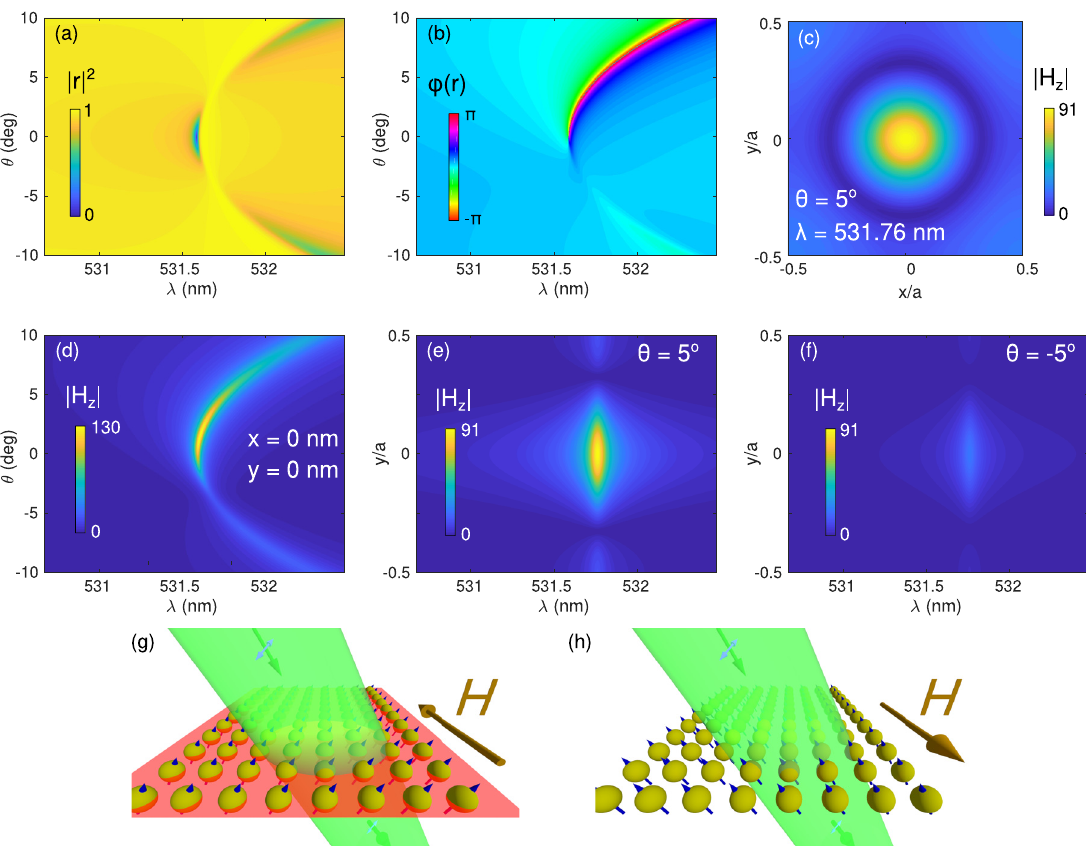
Figure 4: (a and b) Contour maps of the (a) intensity and (b) phase of the reflectance complex amplitude r ( 𝜔 ) (where R ( 𝜔 ) = | r ( 𝜔 ) | 2 ) for TE polarization from an infinite square array of lossless semiconductor ( n = 3 . 5) nanospheres (lattice period a = 300 nm, sphere diameter D = 150 nm), as in Figure 2a and c , but for fixed MO activity 𝛽 = 1, as a function of the angle of incidence and wavelength 𝜆 , theoretically calculated through CEMD, exploring the angular dependence of the MD quasi-BIC. (c–f) Contour maps of the amplitude of the vertical magnetic near-field, calculated also through our analytical CEMD theory, all of them at a distance of z = 100 nm above the square array: (c) within a unit cell at the wavelength ( 𝜆 = 531 . 76 nm) and angle 𝜃 = 5 ◦ of the Brewster quasi MO-BIC; (d) spectral and angular dependence as in (a and b); (e and f) spectral dependence of cuts along one of the in-plane axes within the unit cell, at two fixed angles of incidence (e) 𝜃 = 5 ◦ and (f) 𝜃 = − 5 ◦ (equivalent to two antiparallel magnetic field directions at a fixed angle of incidence). (g and h) Illustration of the switching concept based on reversing the direction of the magnetic field at a fixed angle of incidence, (g) with and (h) without coupling into the Brewster quasi-BIC, equivalent to the configurations based on symmetric angles of incidence and fixed magnetic field shown, respectively, in (e) and (f).